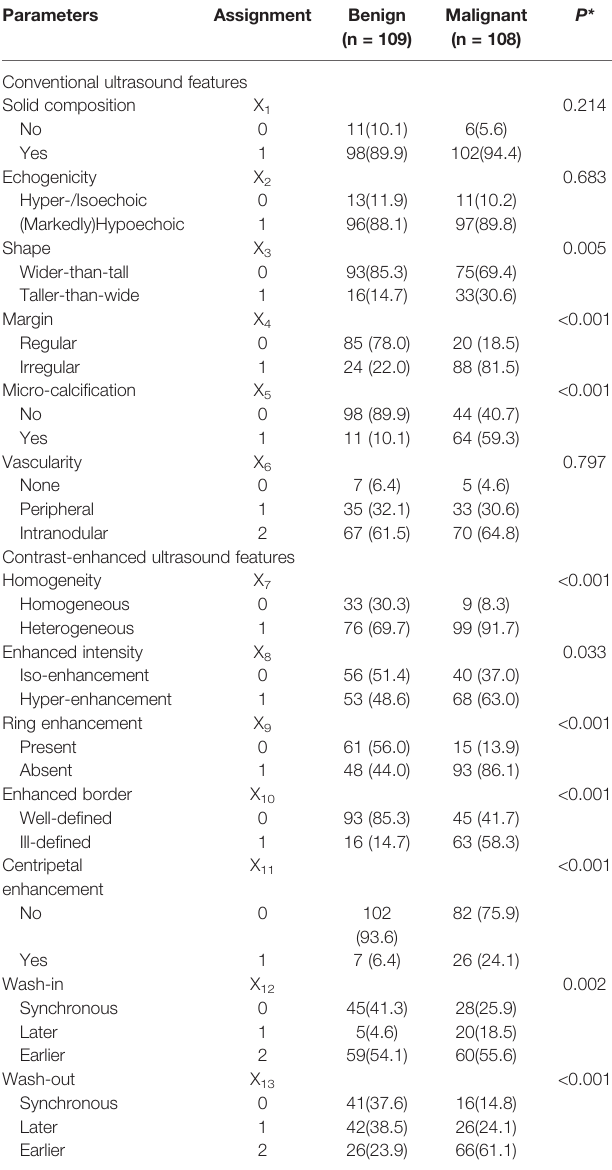
TABLE 2 | Sonographic features of benign and malignant non-hypovascular thyroid nodules in the derivation cohort.